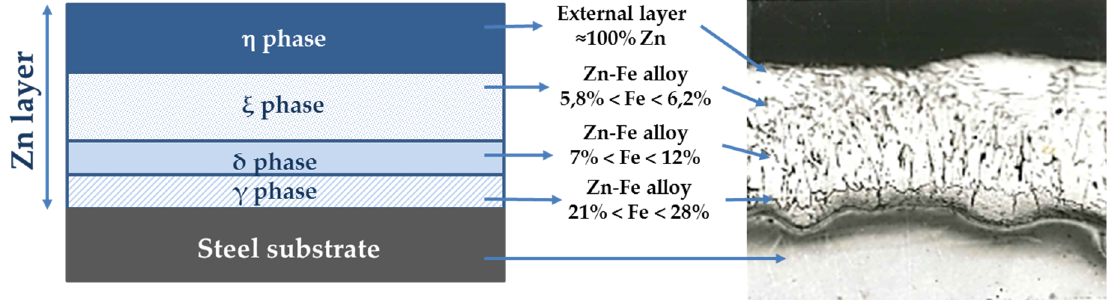
Figure 4. Microstructure and intermetallic layers with the respective content of Fe in hot-dip galvanized steel (HDGS) (adapted from [152]).